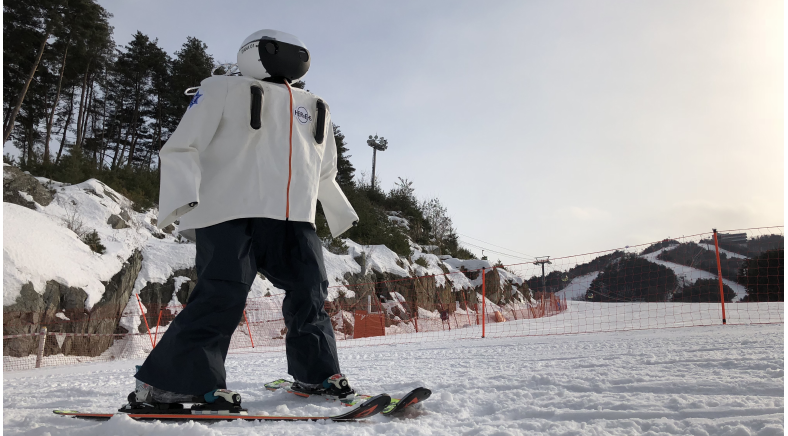
Figure 4. DIANA’s waterproof